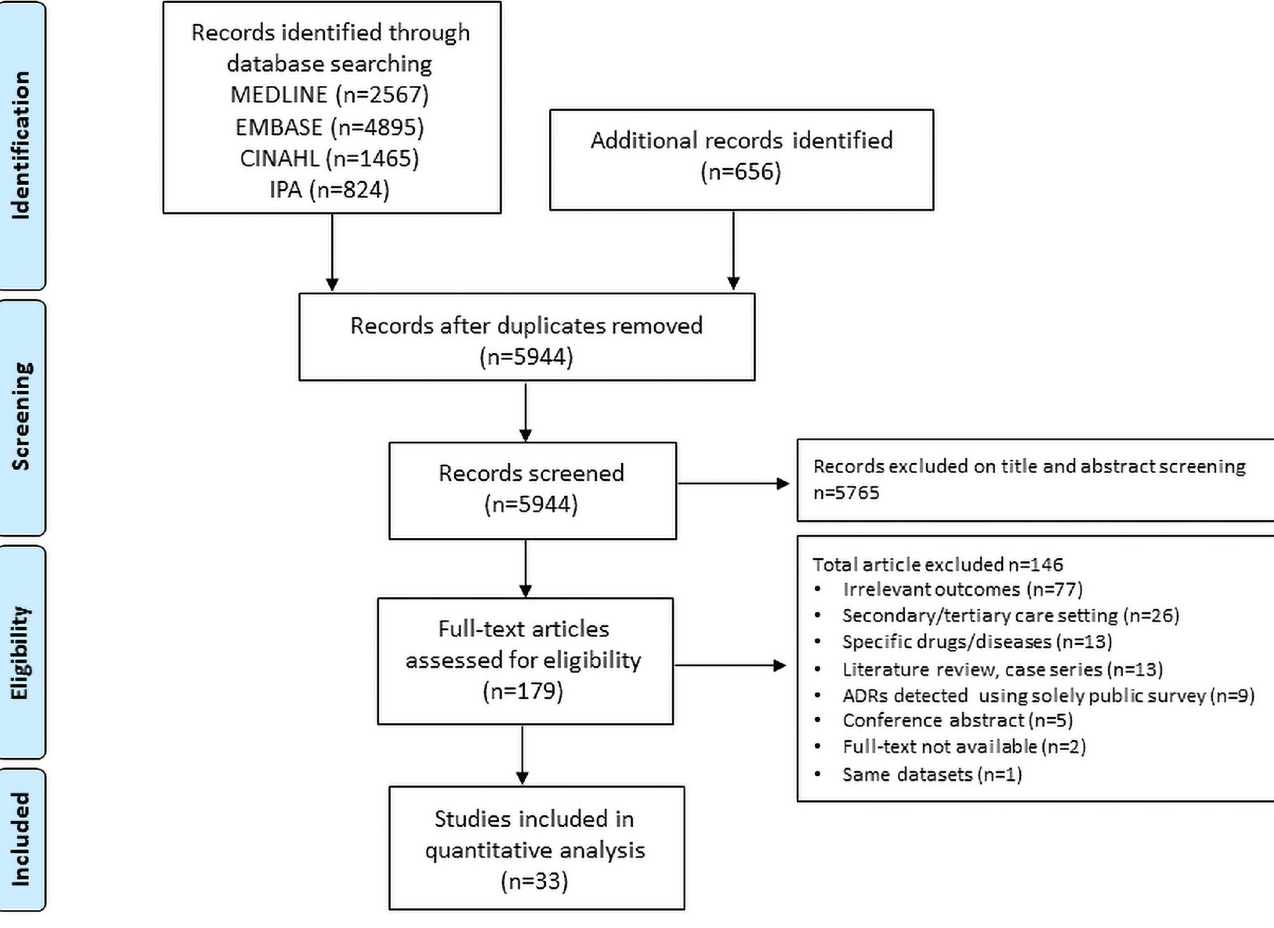
Fig 1. Flow diagram of the selection of eligible